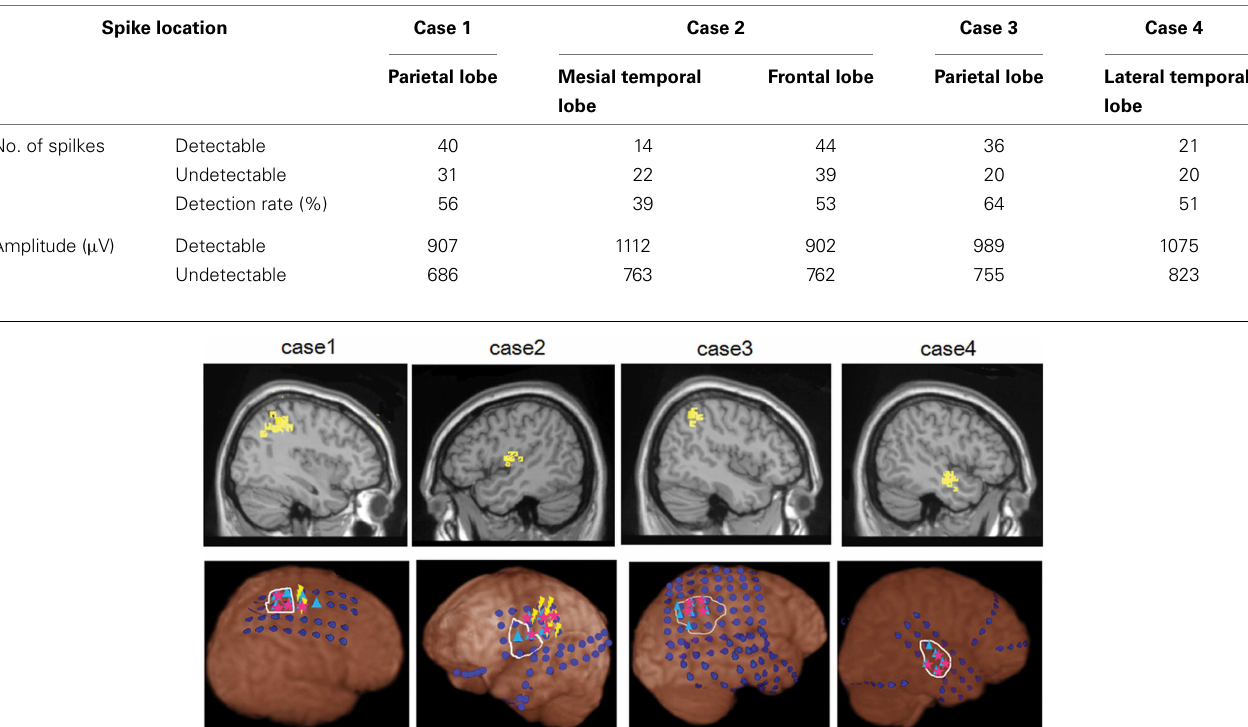
Table 2 | Spike detection rate.